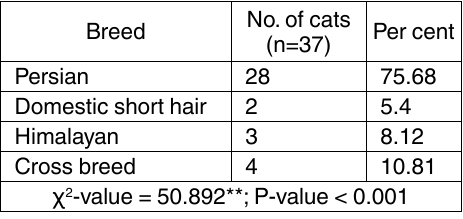
table 1 . Breed-wise occurrence of FLUTD